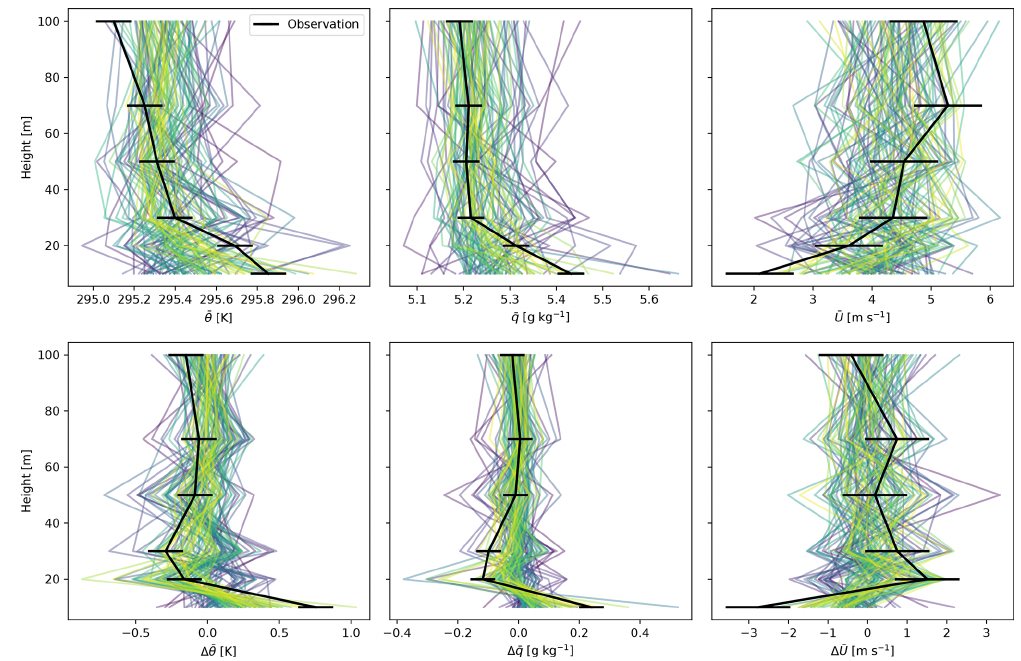
Figure 5. Drone observations and posterior ensemble predictions from the ES-MDA for flight 1 of the Iškoras campaign, a step profile on 27 July 2020 with takeoff at 15:20 local time. The upper panels show the successive 2min mean values, whereas the lower panels show the local mean gradients. The line colors of the vertical profiles for the N e = 100 posterior ensemble members from the ES-MDA correspond to their log likelihood, with more likely values in yellow and less likely values in blue. The prior predictions are not shown because their range is so wide that one could not see any details in the posterior profiles.